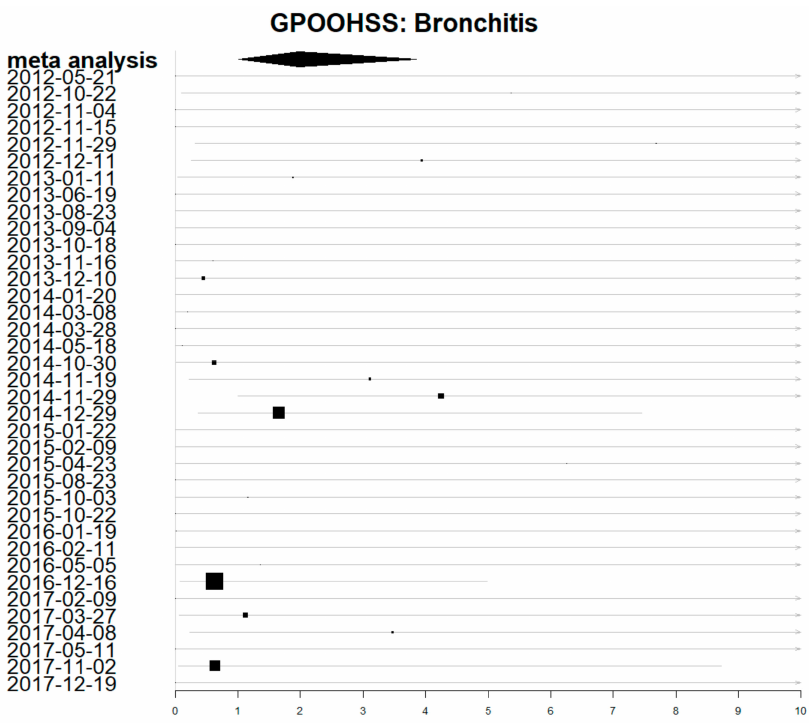
Figure 3. Forest plot showing estimates of rate ratio for the impact of air pollution on GP out-of-hours acute bronchitis consultations. Dates are the first day of each exposure period. Larger boxes depict more precise estimates which contribute more weight.